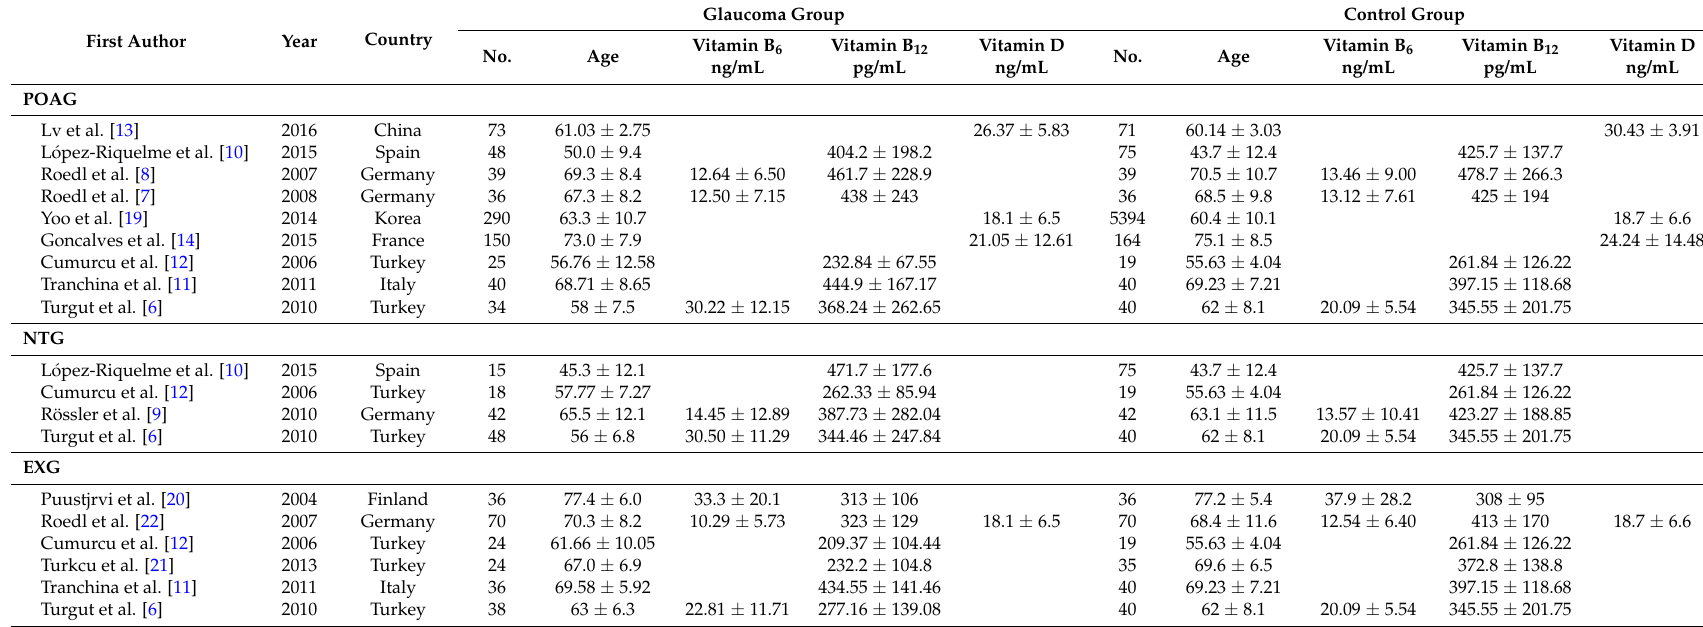
Table 1. Characteristics of Studies of Vitamin B 6 , Vitamin B 12 , and Vitamin D with Different Types of